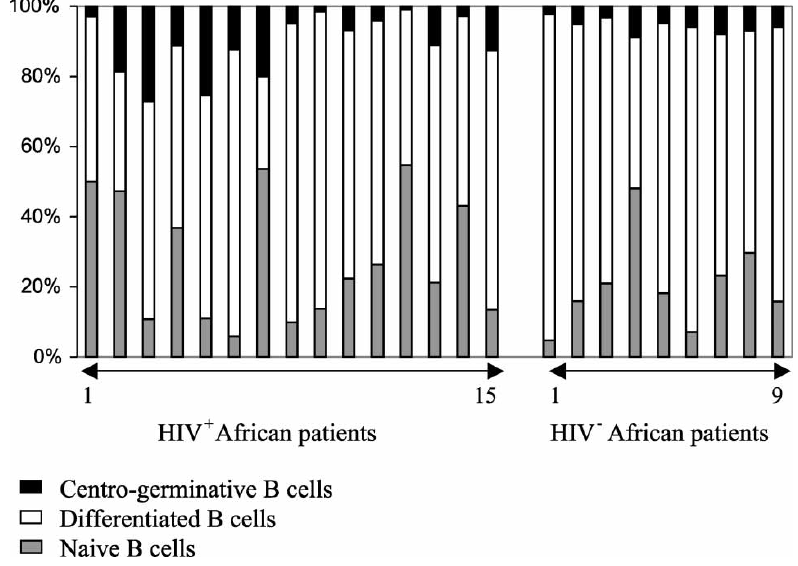
FIGURE 1 Blood B cell phenotype in HIV þ African donors. The bar diagrams show the differential proportion of naive, differentiated and centro- germinative B cells in the periphery (i.e. blood circulating) of HIV-infected, untreated Africans. CD20 þ , sIgM þ sIgD þ cells are naive B cells (gray bars); CD20 þ sIgM ^ , sIgD 2 cells are differentiated B cells (white bars); and CD20 þ , sIgM 2 sIgD þ cells are centro-germinative B cells (black bars). The analysis shows data obtained with blood from 15 HIV-1 infected patients and 9 HIV-negative patients.